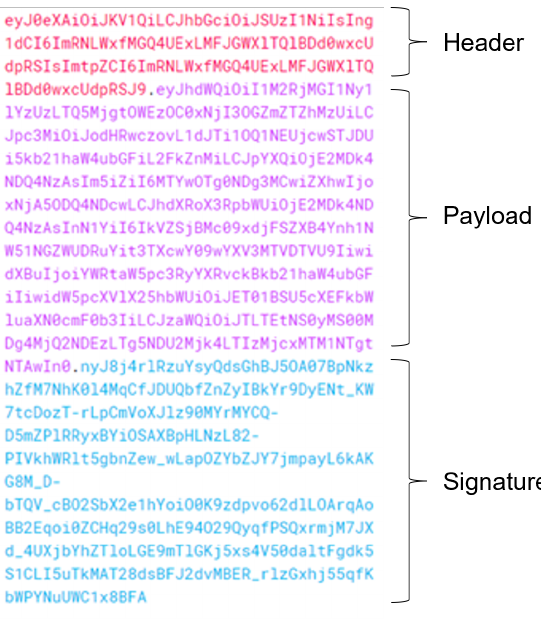
Figure 5. Sample Registration